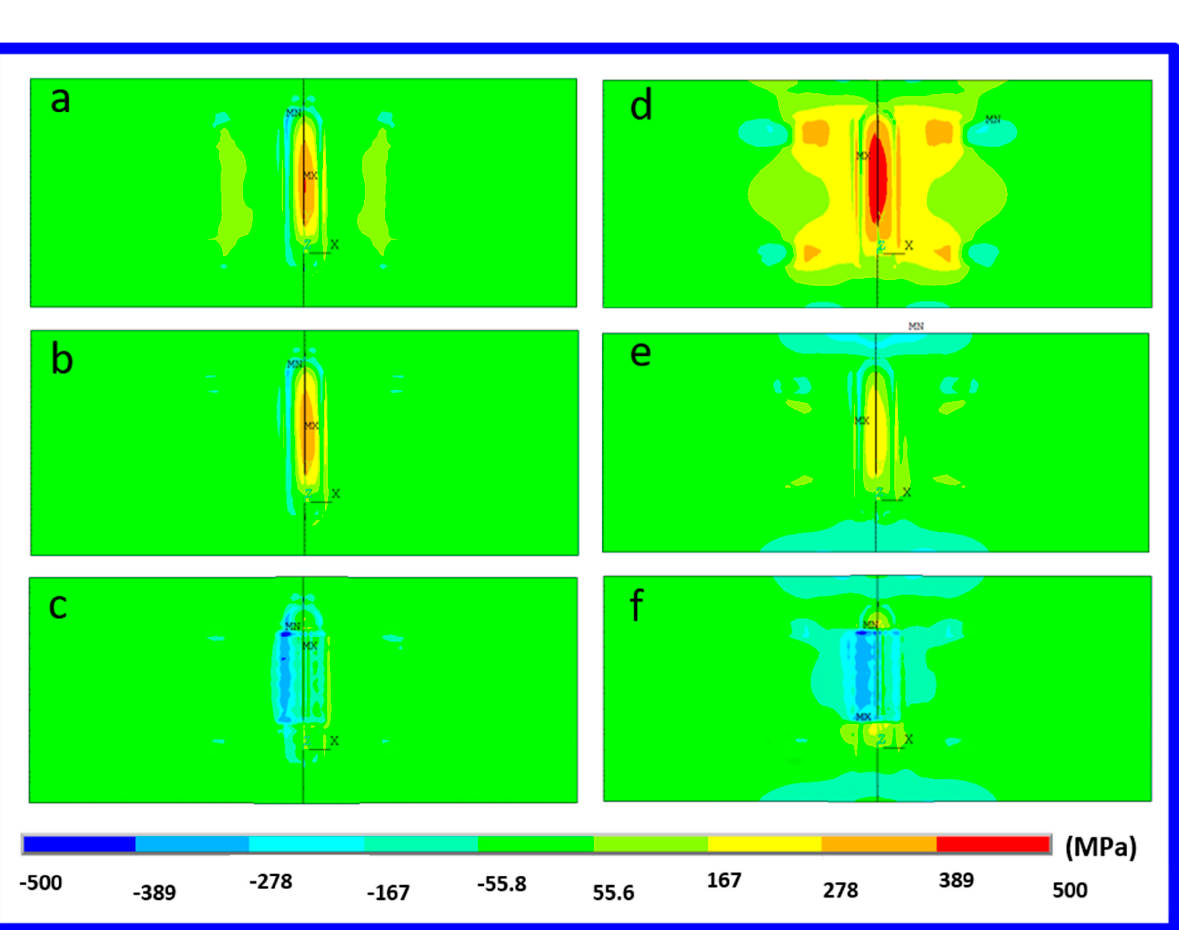
Figure 15. Evolution of stress during the FSW+ BB process for Test 2: longitudinal stress ( a ) before and ( b ) after the release of the fixture, and ( c ) after BB; transverse stress ( d ) before and ( e ) after the release of the fixture, and ( f ) after BB. (MX and MN shown in the figure are maximum and minimum values of residual stress, respectively).